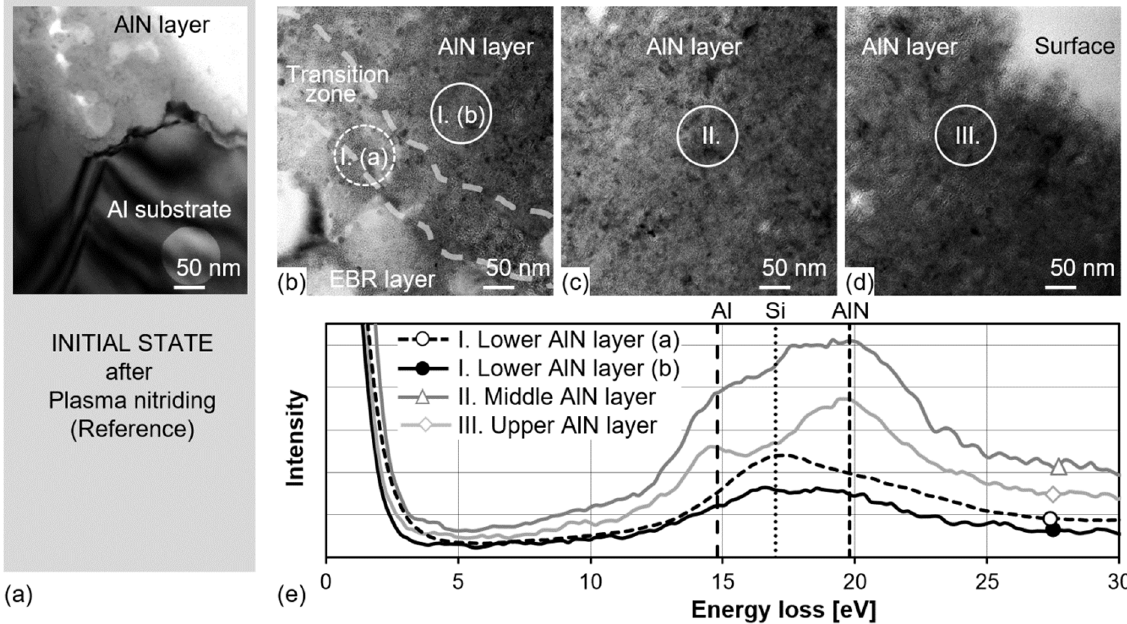
Figure 7. TEM images from AlN layer after ( a ) plasma nitriding (initial state) and after subsequent EBR at different distances, ( b ) lower part of the AlN layer (transition zone), ( c ) middle part, and ( d ) upper part with marked areas of SAED analysis (I.–III.) and ( e ) corresponding EEL spectra.